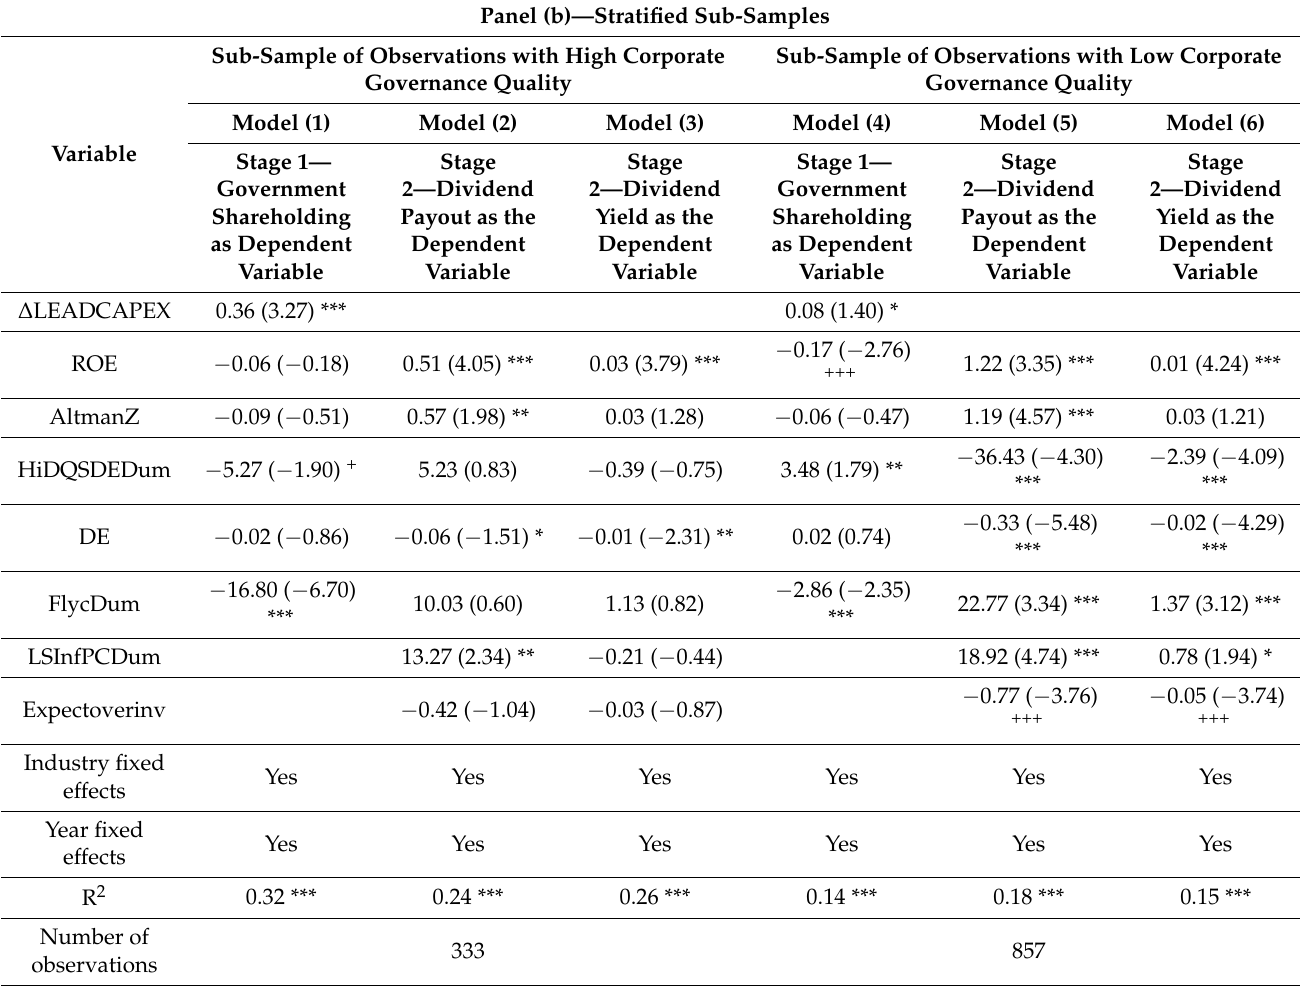
Table 4. Cont . Panel (b)—Stratified